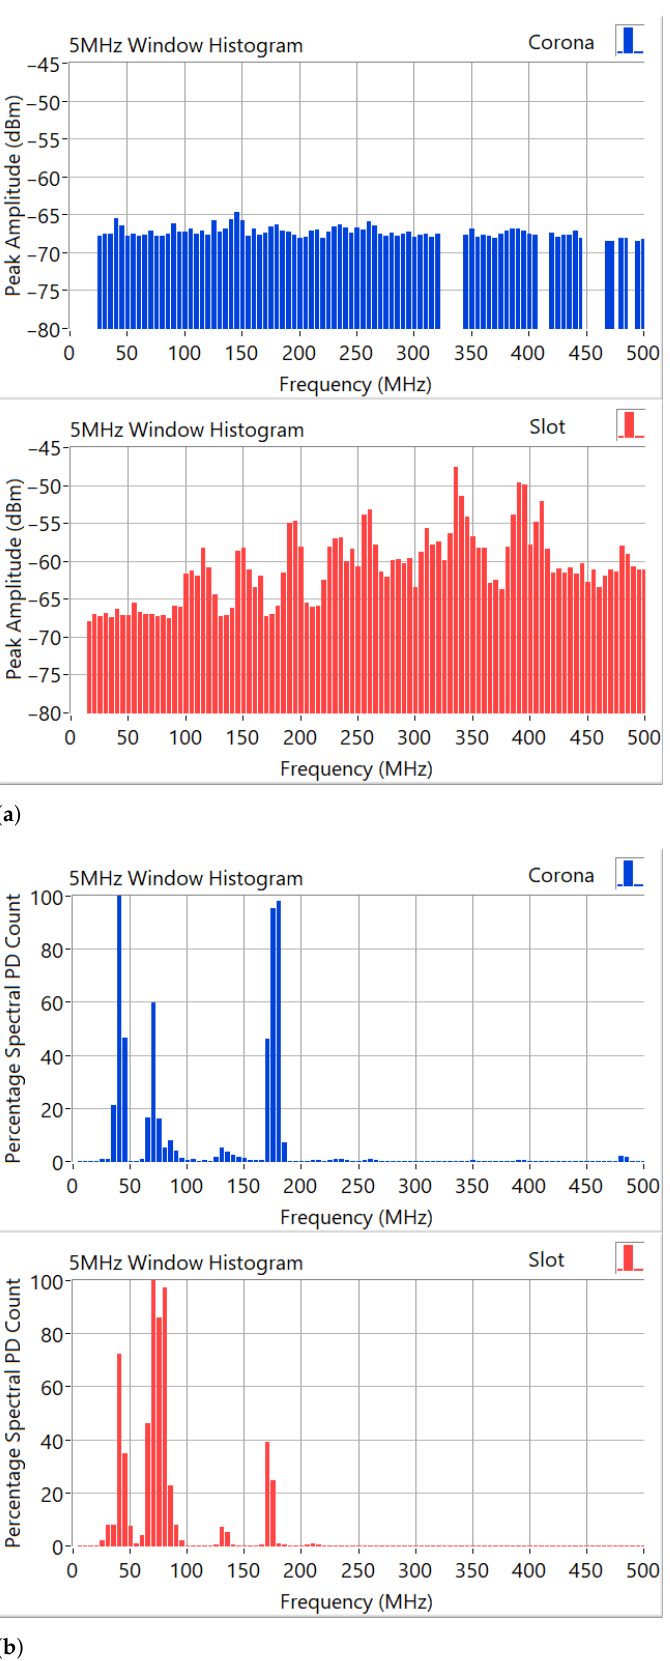
Figure 8. Spectral histograms of corona and slot PDs: ( a ) peak amplitude histograms and ( b ) normal- ized (percentage) pulse count